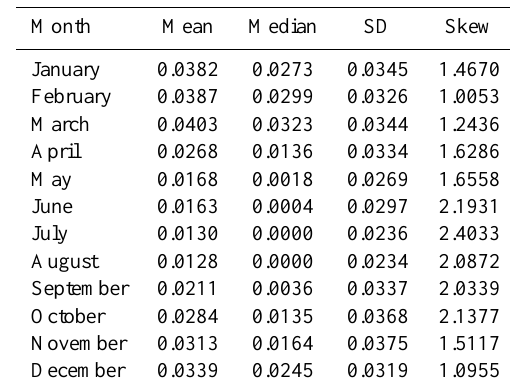
Figure 7. τ(q) for summer and winter of 2001 and 2004.